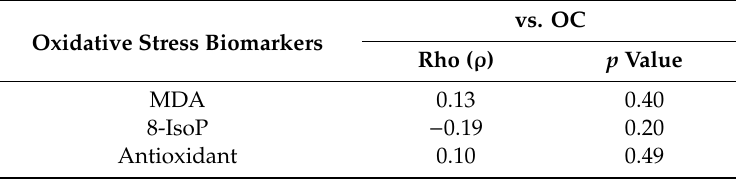
Table 9. Correlation between OC and oxidative stress biomarkers in the study participants (Spearman rank correlation